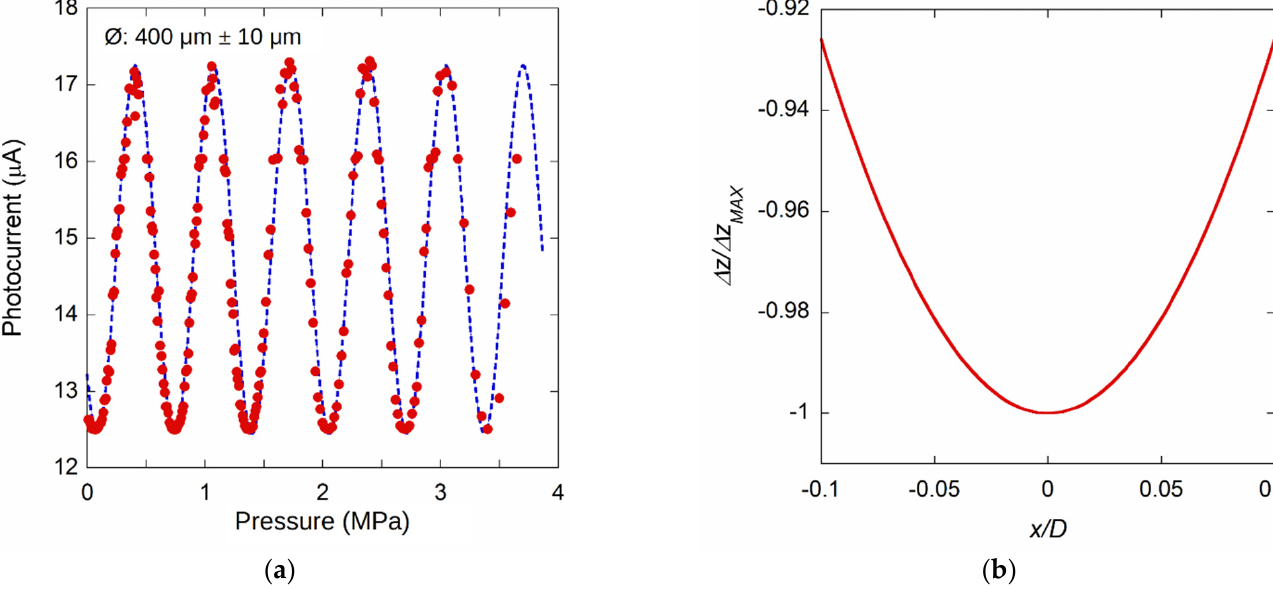
Figure 9. ( a ) Photocurrent signal acquired for a membrane of about 400 μ m diameter, for pressures up to 3.6 MPa. The dotted line represents the best fit of the experimental data according to Equation (2). ( b ) A simulation of the displacement per unit of pressure normalized to the maximum, as a function of the x position normalized to the membrane diameter D .